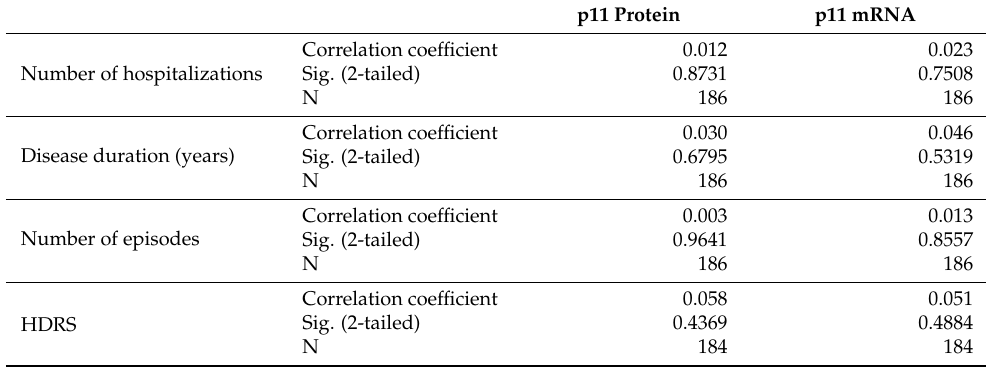
Table 3. Spearman’s rho correlations of p11 gene expression with clinical variables in the test group (depression).